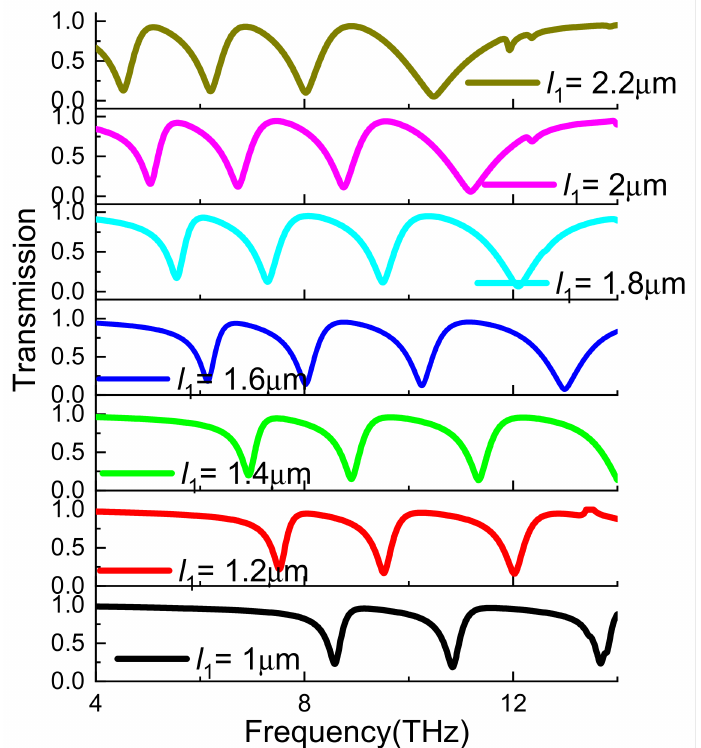
Figure 9. Simulated transmission spectra of the proposed A-EIT structures with respect to the length of the graphene